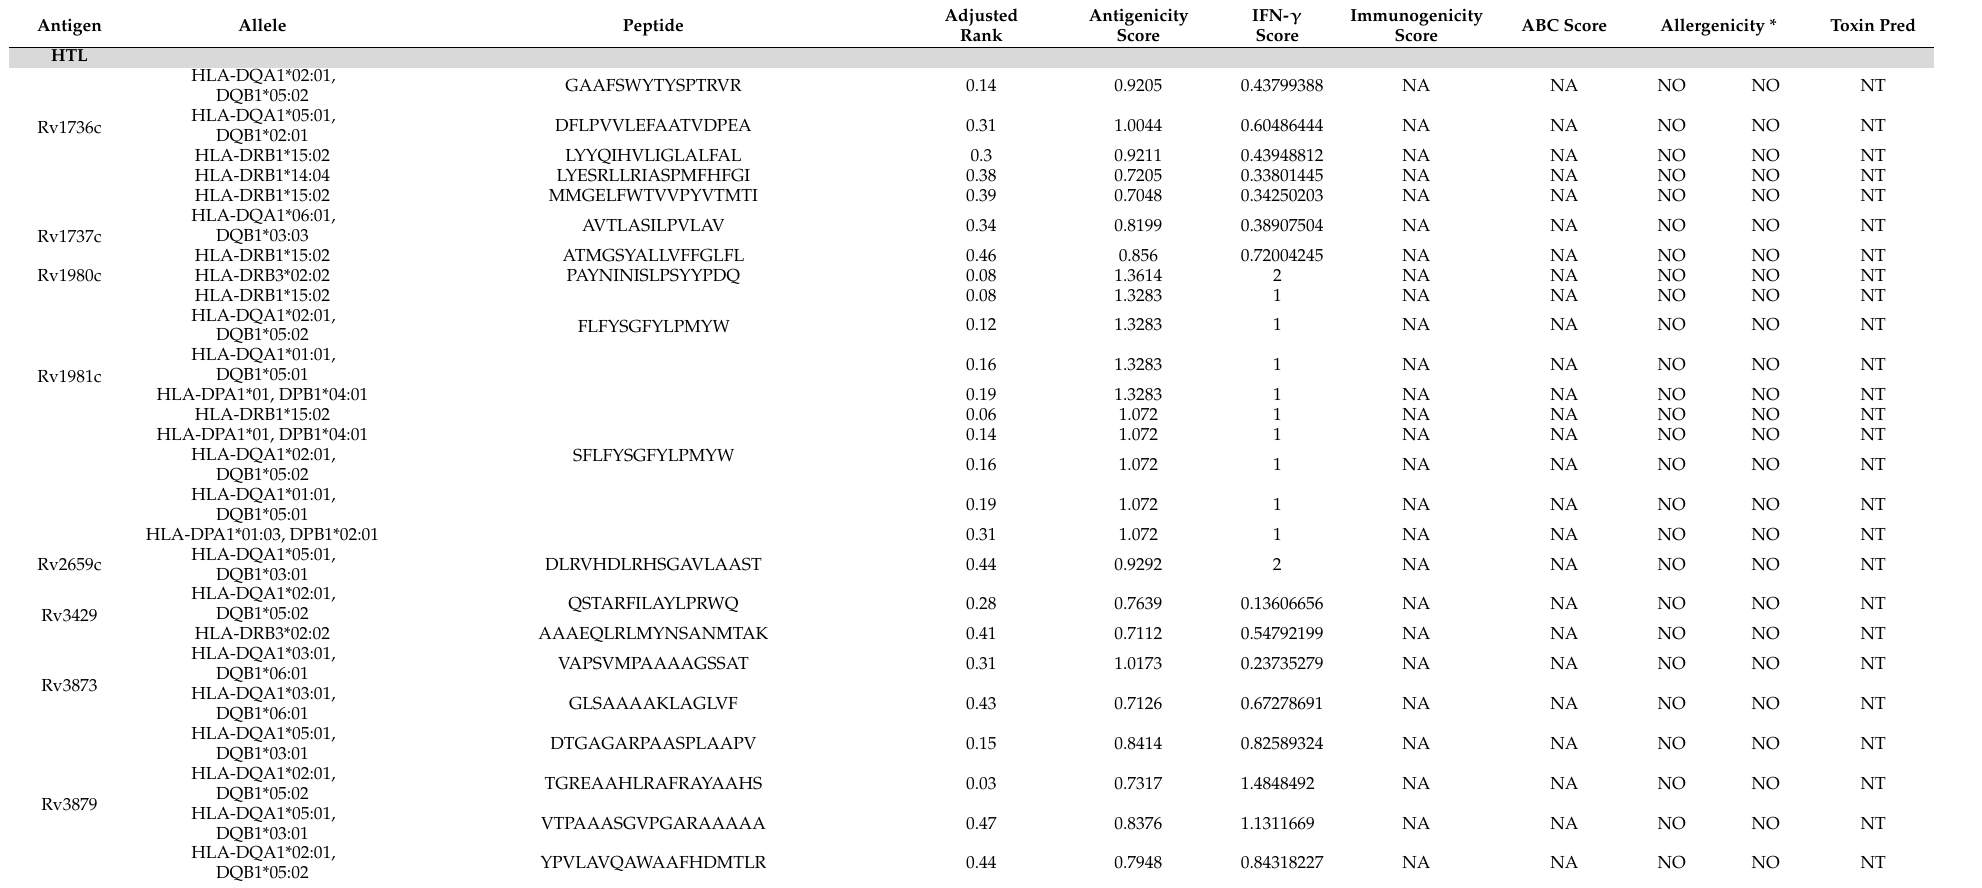
Table 1. The immunodominant HTL, CTL, and B-cell epitopes of the PP19128R